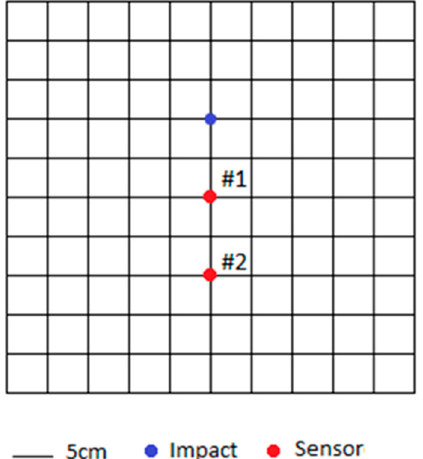
Figure 8. Experimental setup for DToA estimation by S 0 and A 0 mode signals. PI-976.SP1 piezoelectric sensors #1 and #2 are at 10 cm distance and 10 cm and 20 cm respect to the impact point (blue dot). The aluminum plate dimensions are: 500 mm × 500 mm × 1.4 mm.